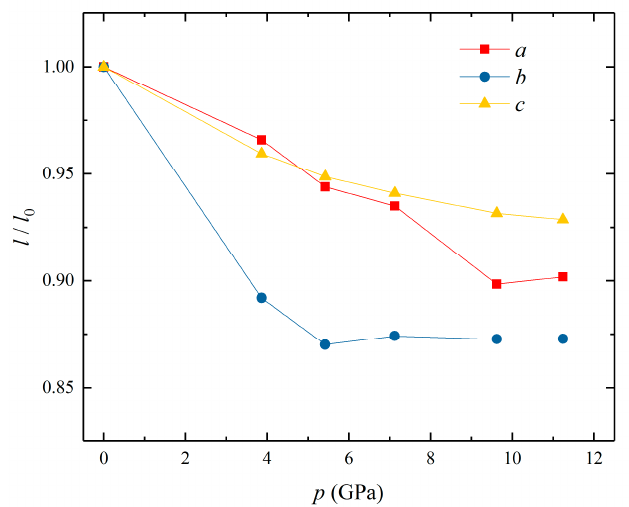
Figure A1. Relative changes in crystallographic lattice parameters as a function of pressure, based on experimental single crystal structure determinations. a , b , and c are shown as red squares, blue circles and yellow triangles, respectively.